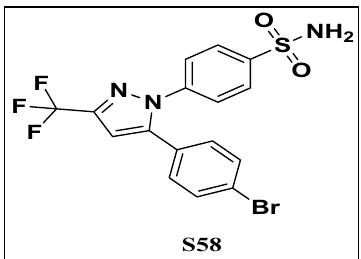
Figure 2. Co-crystallized ligand S58 [4-(5-(4-bromophenyl)-3-(trifluoromethyl)- 1H -pyrazol-1yl) benzenesulfonamide].